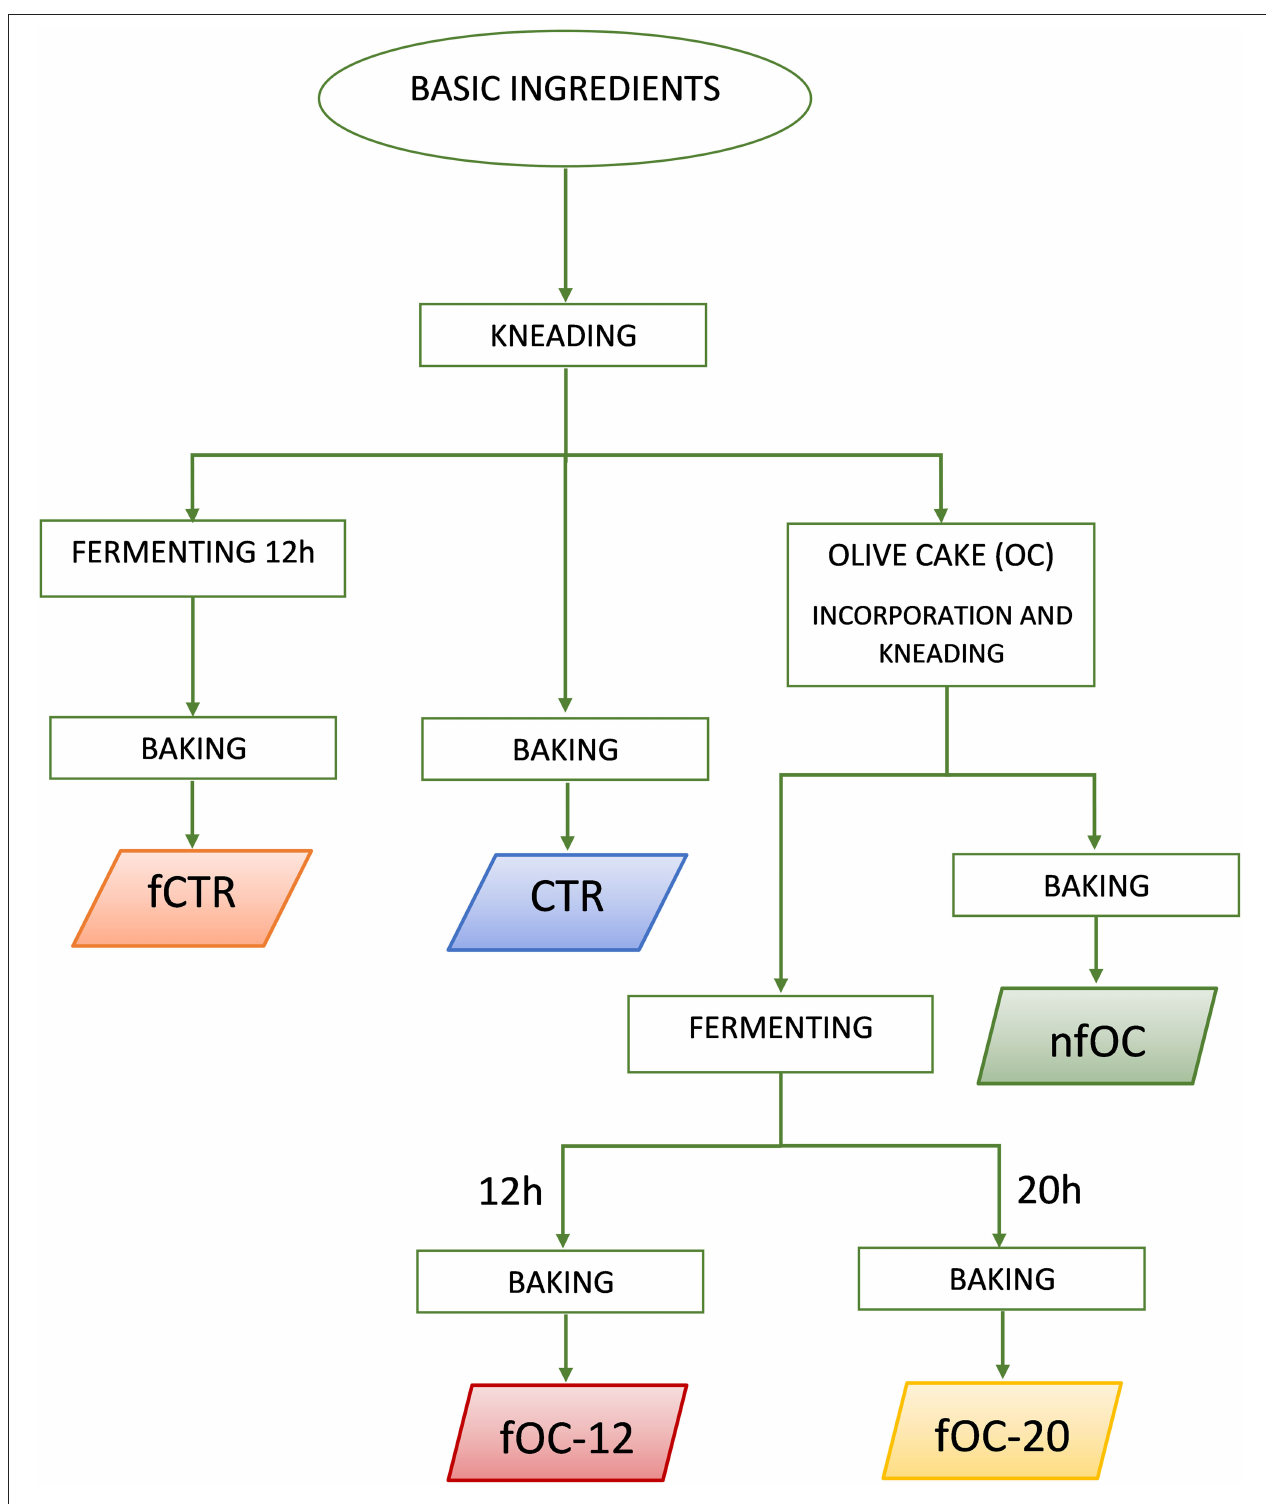
FIGURE 1 | Flowchart of the breadstick sampling. CTR, control breadsticks obtained by the dough without olive cake (OC) addition and without microbial fermentation; fCTR, breadsticks obtained by the dough without OC addition and fermented; nfOC, breadsticks obtained by the dough supplementation with 1% OC without microbial fermentation; fOC-12, breadsticks obtained by the dough supplementation with 1% OC and fermented for 12h; fOC-20, breadsticks obtained by the dough supplementation with 1% OC and fermented for 20h.